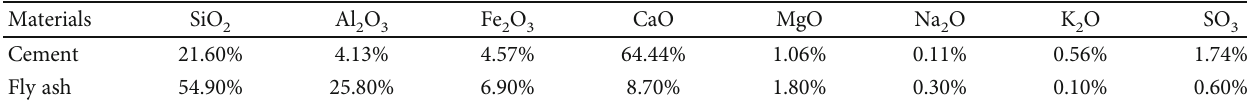
Table 1: Chemical composition of cement.